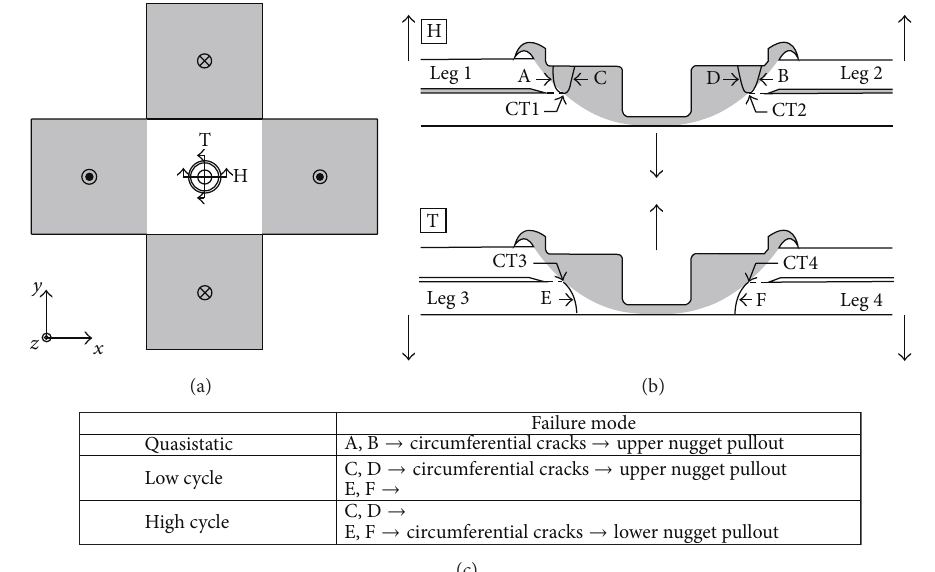
Figure11:Schematicsof(a)thetopviewofacross-tensionspecimen,(b)thecross-sectionsalongthehorizontal(markedbyH)andtransverse (marked by T) symmetry planes of the spot friction weld, respectively, and (c) the failure modes of spot friction welds under different loading conditions